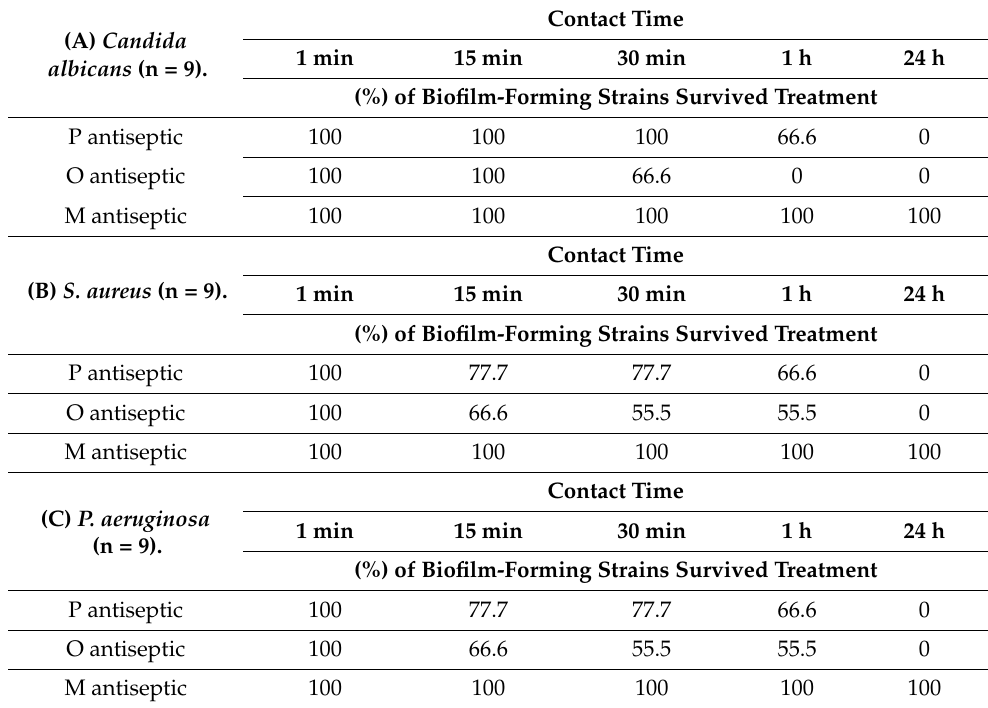
Table 2. Ability of the tested antiseptics to eradicate biofilm of (A) C. albicans , (B) S. aureus and (C) P. aeruginosa measured by biofilm-oriented antiseptic test. P, O, M—plihexanide,